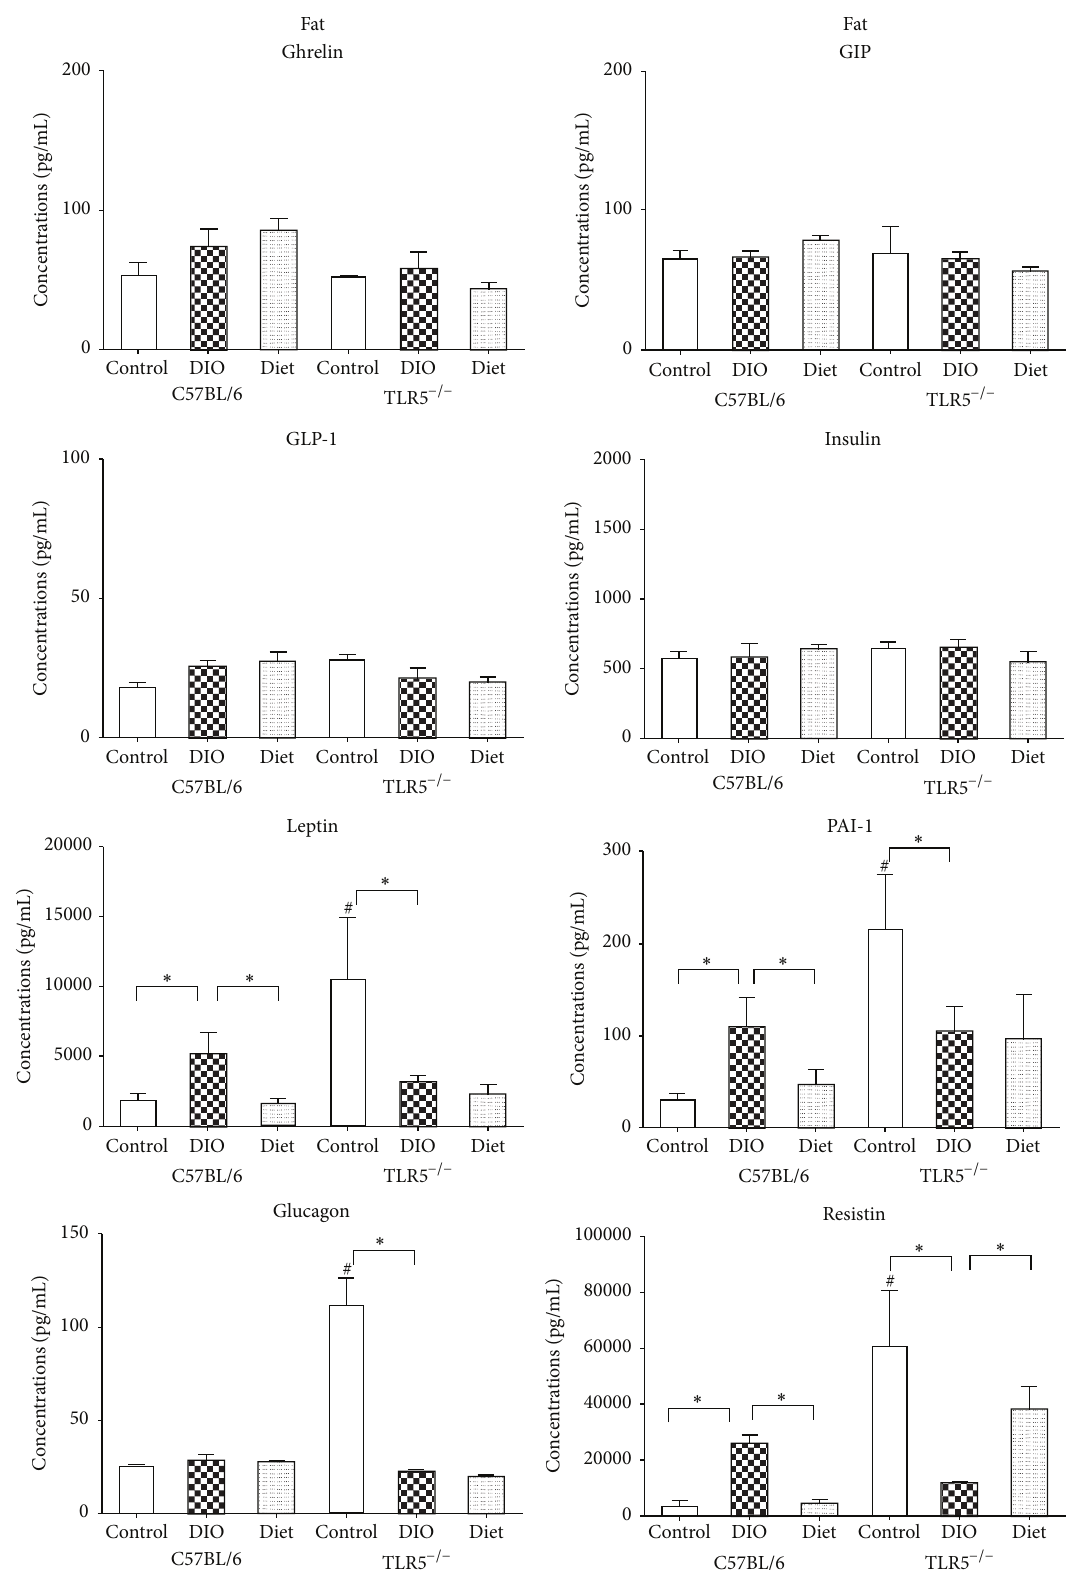
Figure 6: Concentrations of adipose tissue cytokines analyzed by the Bio-Plex Multiplex cytokine assay at week 12 in C57BL/6 and TLR5 −/−